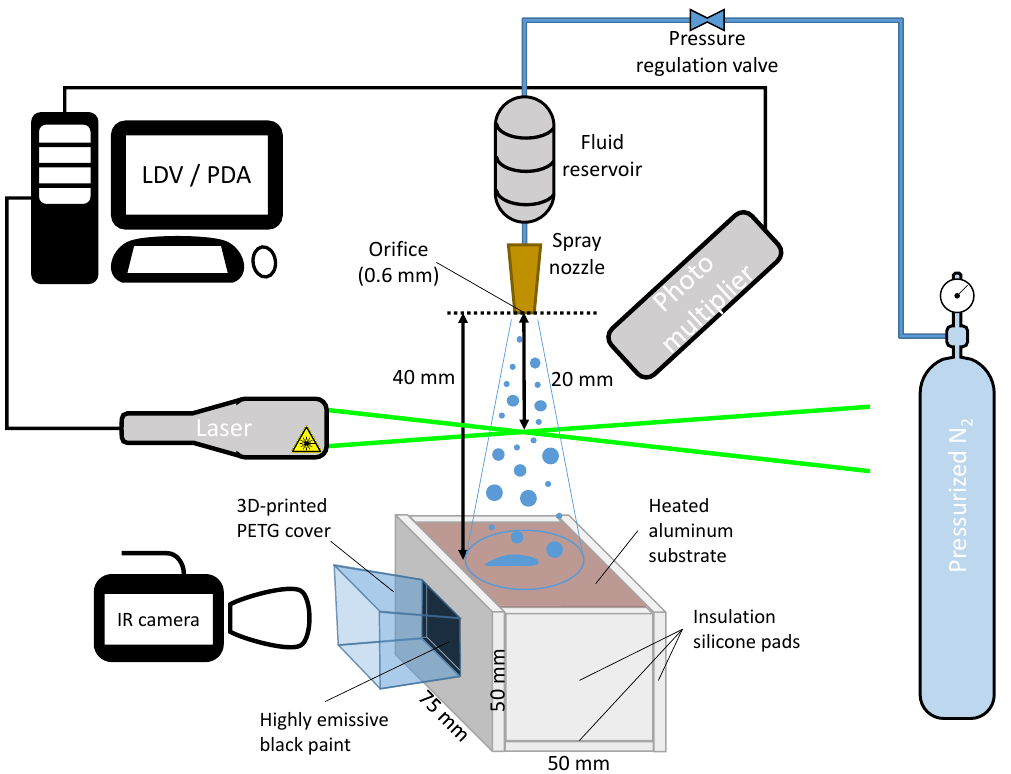
Figure 1. Experimental setup characterizing the nanofluid spray and measuring the temperature of the heated aluminum